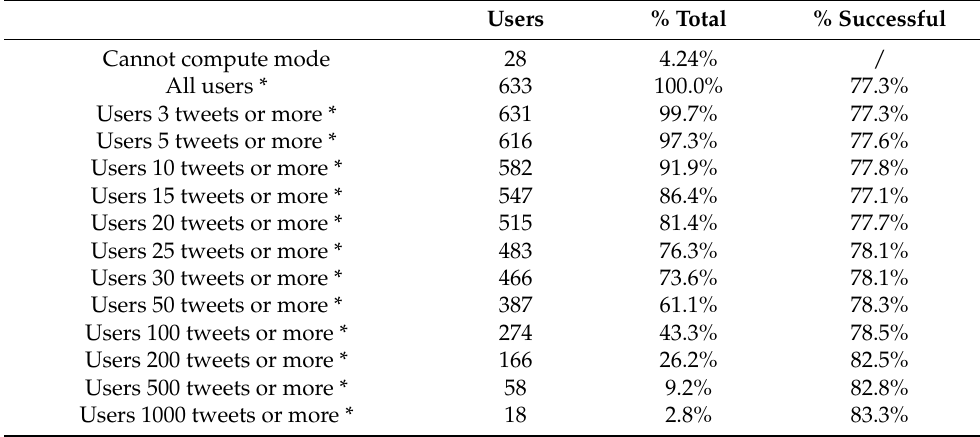
Table 1. Percentages of successful home location identification for different